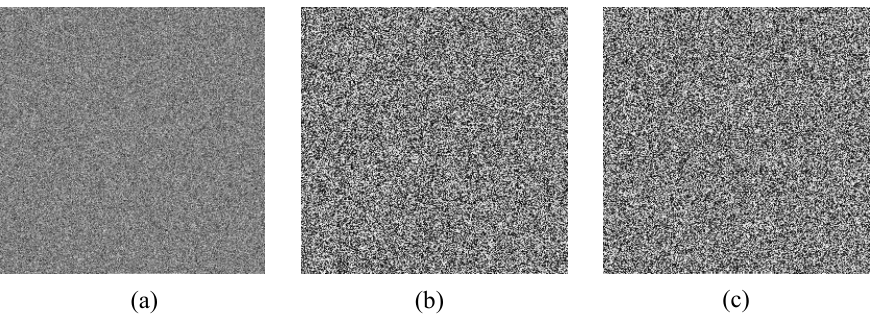
Figure 16. ( a ) User B’s secret key ks ; ( b , c ) are ( Pb + ks × Pa ) , generated in user B’s